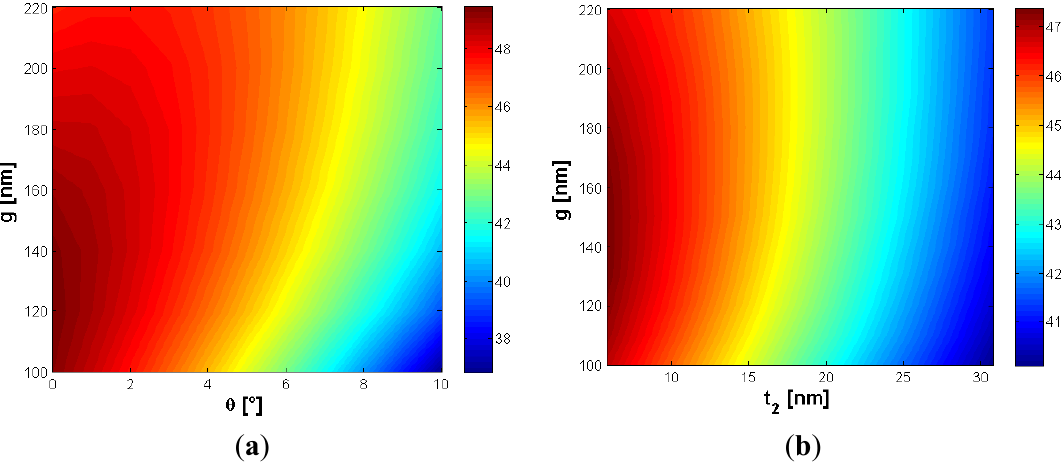
(%) versus ϑ and g , with H = 220 nm and W = 210 nm; ( b ) Γ Figure 3. ( a ) Γ c and g with H = 220 nm, W = 210 nm, and t t 2